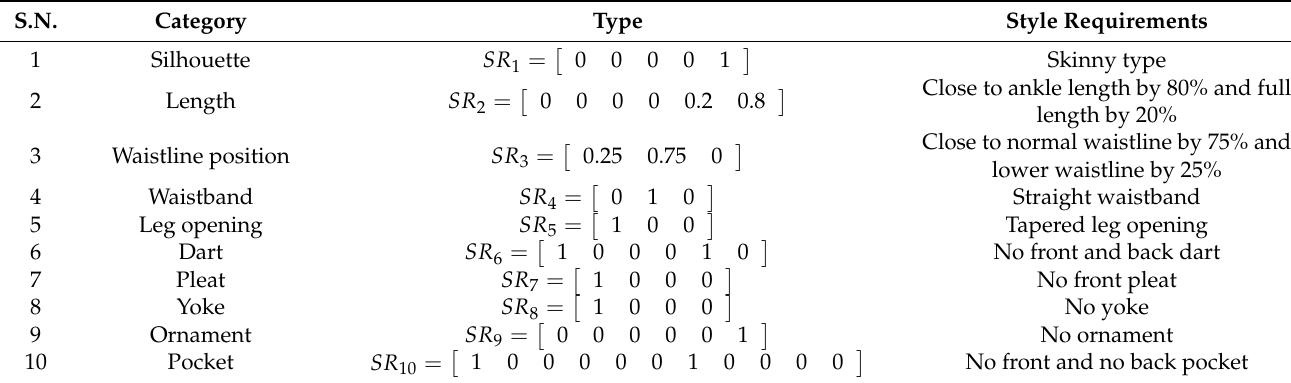
Table 1. The requirements for the pants style elements SR .